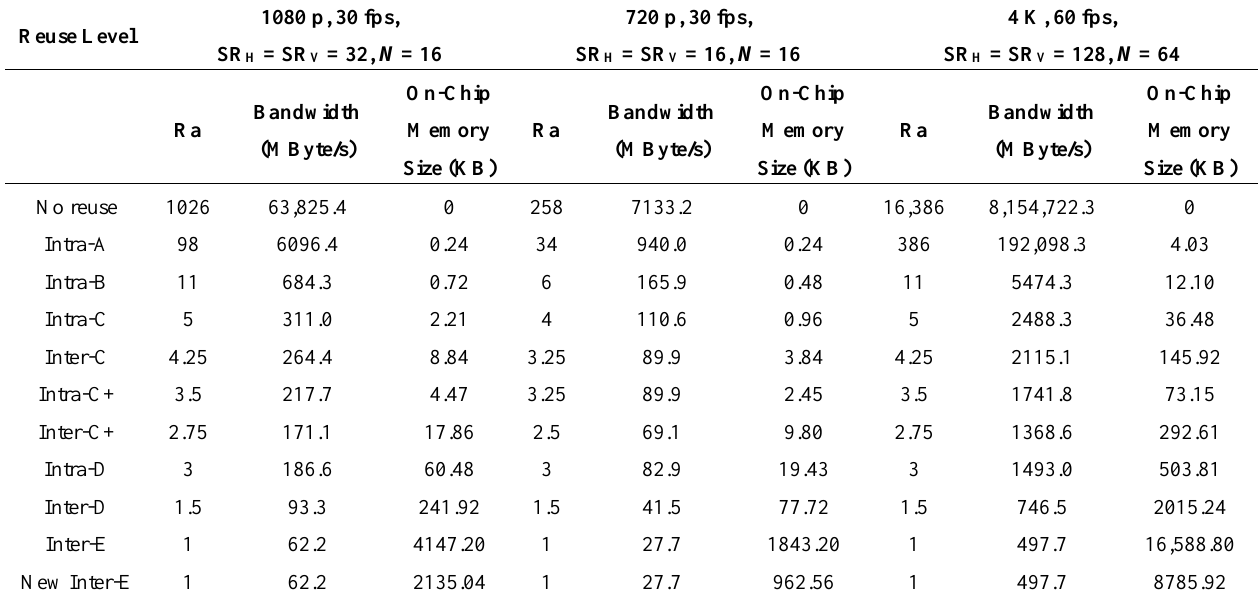
Table 7. Three Case Studies for